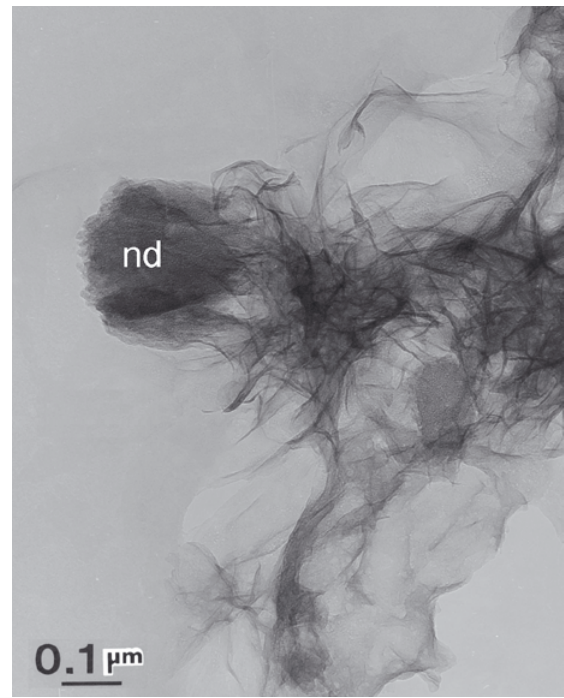
Figure 4. After 15 days, electron-dense nordstrandite granules appear connected with fibrils; here we can see that the nordstrandite particles (nd) and pseudoboehmite fibrils are intimately